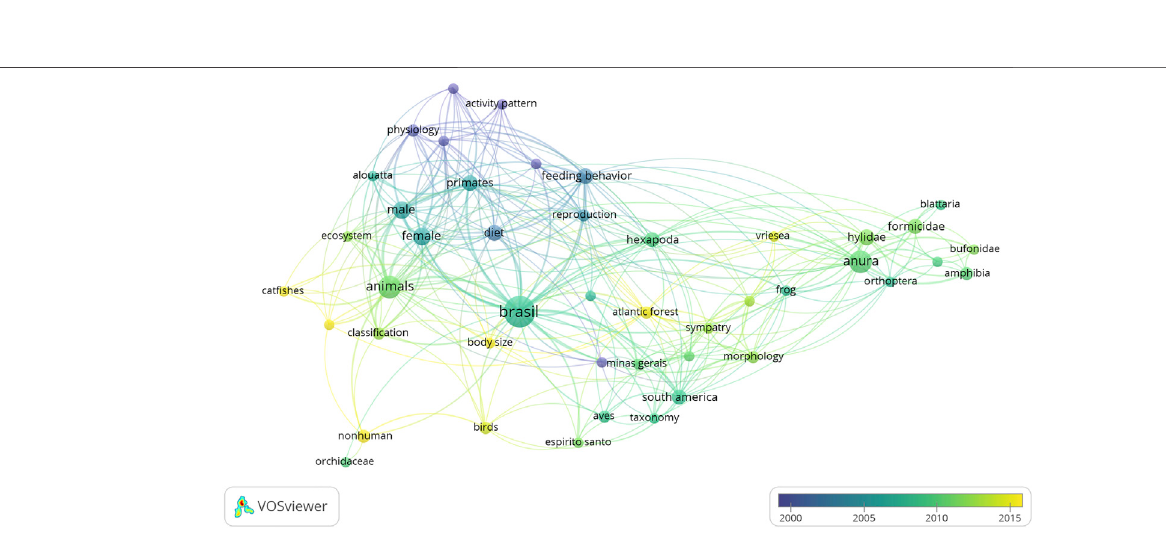
Frontiers in Research Metrics and Analytics |